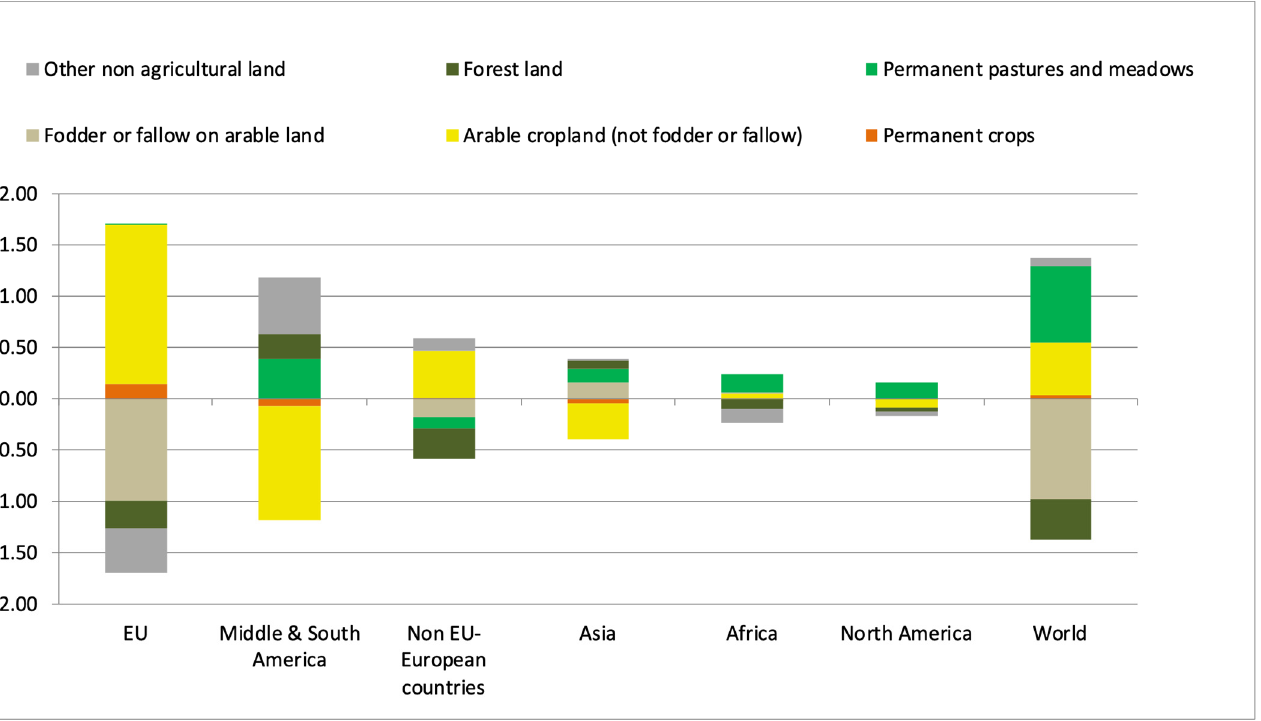
Figure 3. Global land use change in 1000 ha.